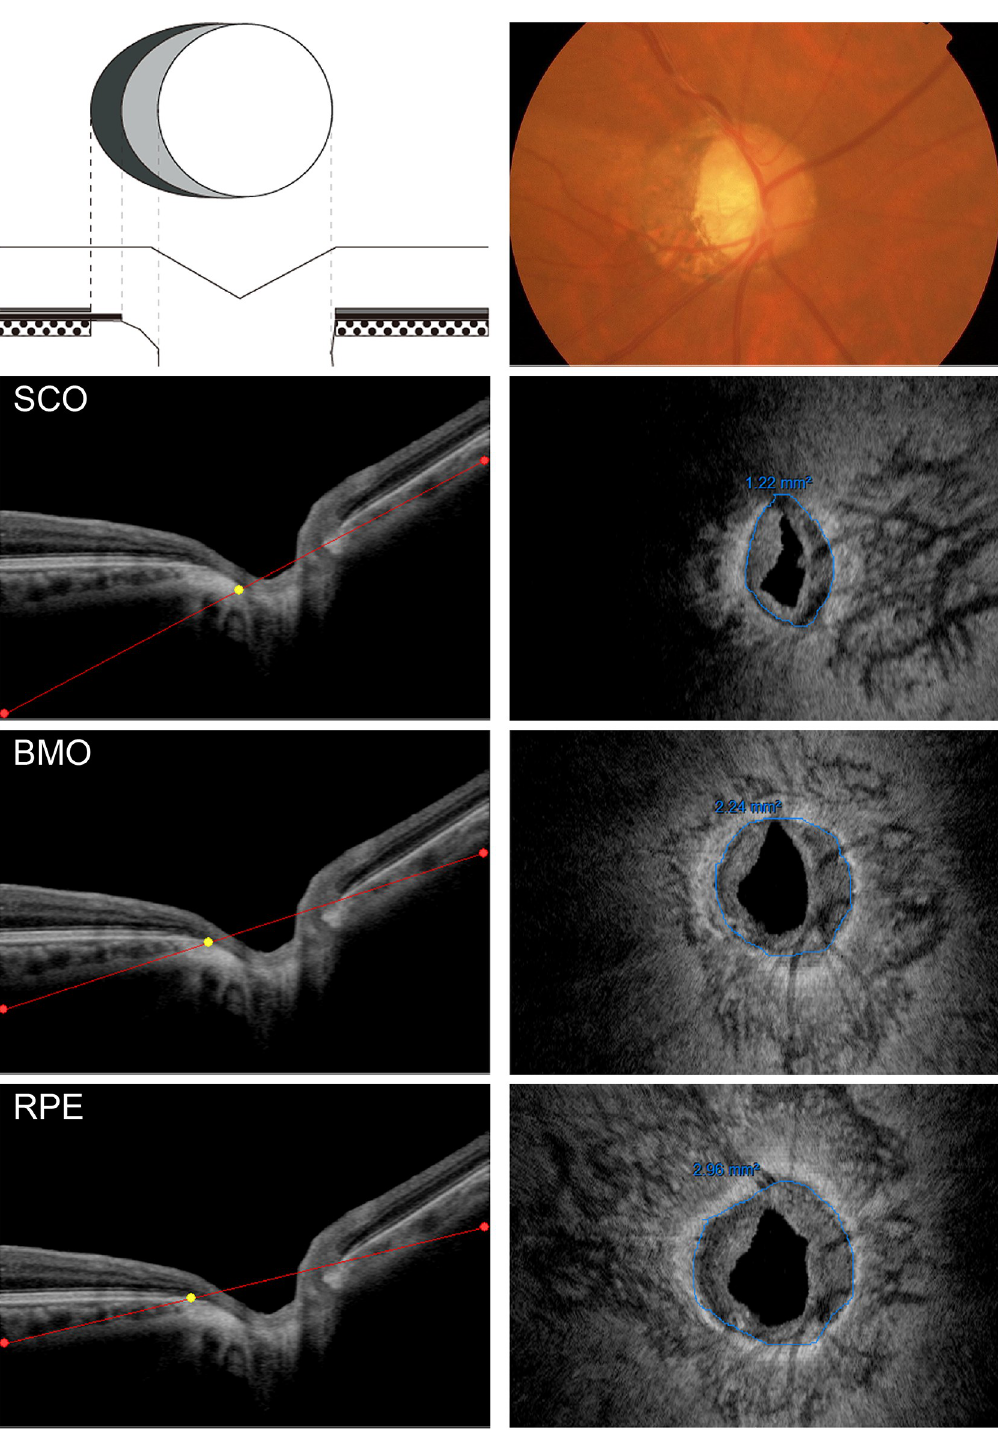
Fig 2. Measurements of the PPA zones. Top) Left panelillustrates the OCT-defined PPA zones. White circle in the above schema represents the optic disc. Grey area aroundoptic disc (bare sclera without overlyingBruch’s membrane) is the gamma zone. Dark grey area (Bruch’s membranewithout overlyingRPE) represents the beta zone. It is difficult to distinguish betweenthe beta zone and the gamma zone on the photograph(right panel). Second from top) Referenceline was placed at the level of the SCO (red line) in a horizontalOCT scan of the same eye. Right panel shows a corresponding en face image. The SCO can be identifiedas a border betweenhighly reflective sclera